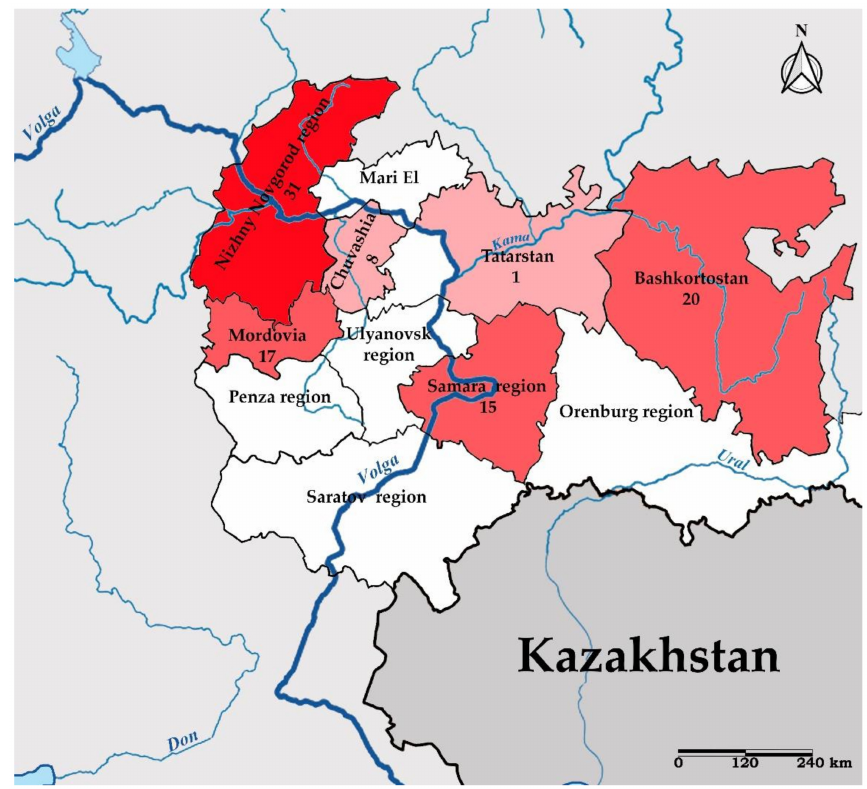
Figure 2. Map of the Middle Volga area showing regions with cases of trematode species reported in the land birds (dark red: more than 20 trematode species found in this region; medium red—10 or more trematode species; light red—fewer than 10 species; white—without helminthological studies of birds. The numbers show the quantity of identified trematode